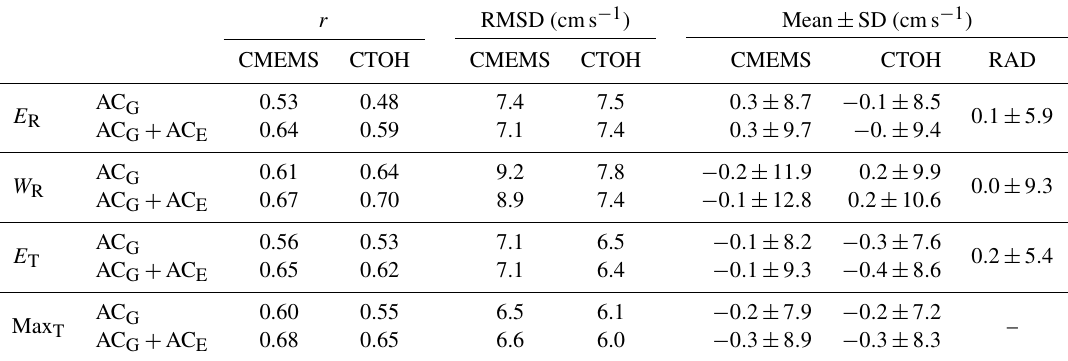
Table 1. Statistics of different points for the study period. r is the correlation parameter, and RMSD is the root mean square difference of the velocity anomalies between HFR and altimetry for different altimetry products (i.e. CMEMS and CTOH). The mean and the standard deviation (SD) are also estimated for each data set. E and W are the points where HFR radial velocities are orthogonal to tracks 248 and 213, respectively (see Fig. 1). E T means that the parameters are estimated at point E but using the HFR current velocity anomaly fields rotated to across-track direction instead of using the HFR radial velocity anomalies. That HFR data have also been used for Max T , which is the track point where the correlation r is maximal (point 2.10 ◦ W, 43.82 ◦ N for CTOH and point 2.09 ◦ W, 43.80 ◦ N for CMEMS). RAD refers to HFR data, which really means radial anomaly current for E R and W R and across-track rotated OMA anomaly currents for E T and Max T . There is no data in Max T because they are different for each altimetry product. r RMSD (cms − 1 ) Mean ± SD (cms − 1 ) CTOH